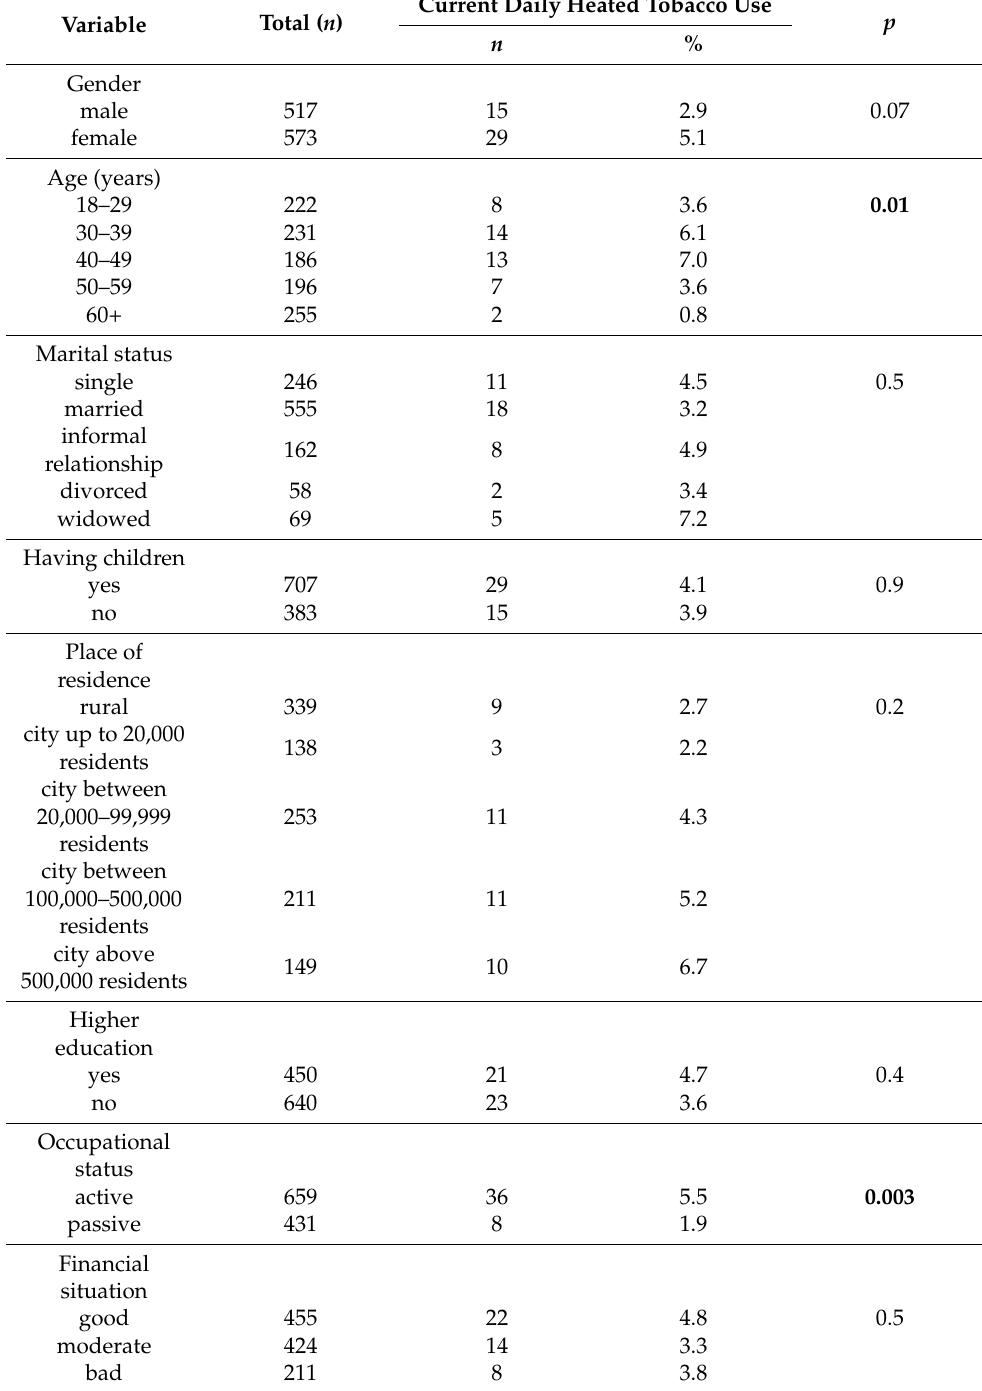
Table 5. The prevalence of heated tobacco use among adults in Poland, n =